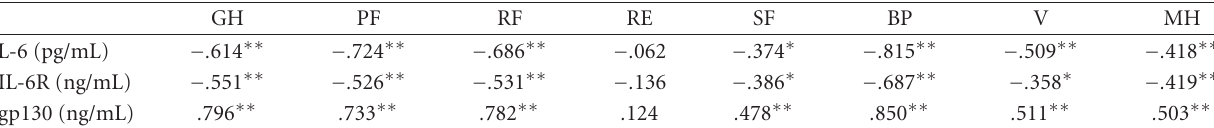
Table 3: Pearson correlation coe ffi cients among biological measures and quality of